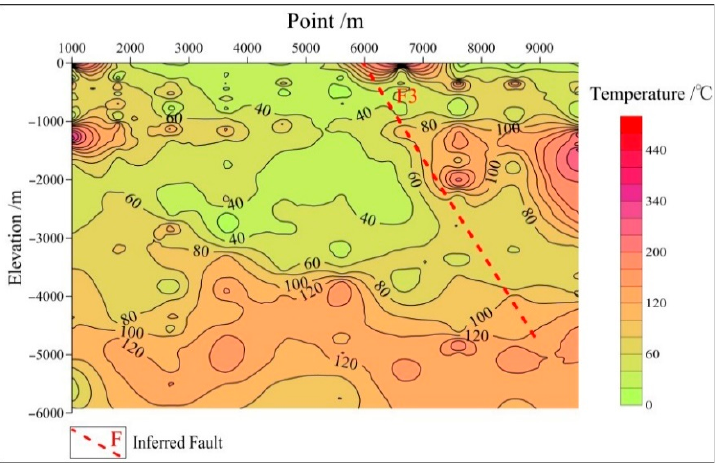
Figure 10. Temperature profile of survey line L3.